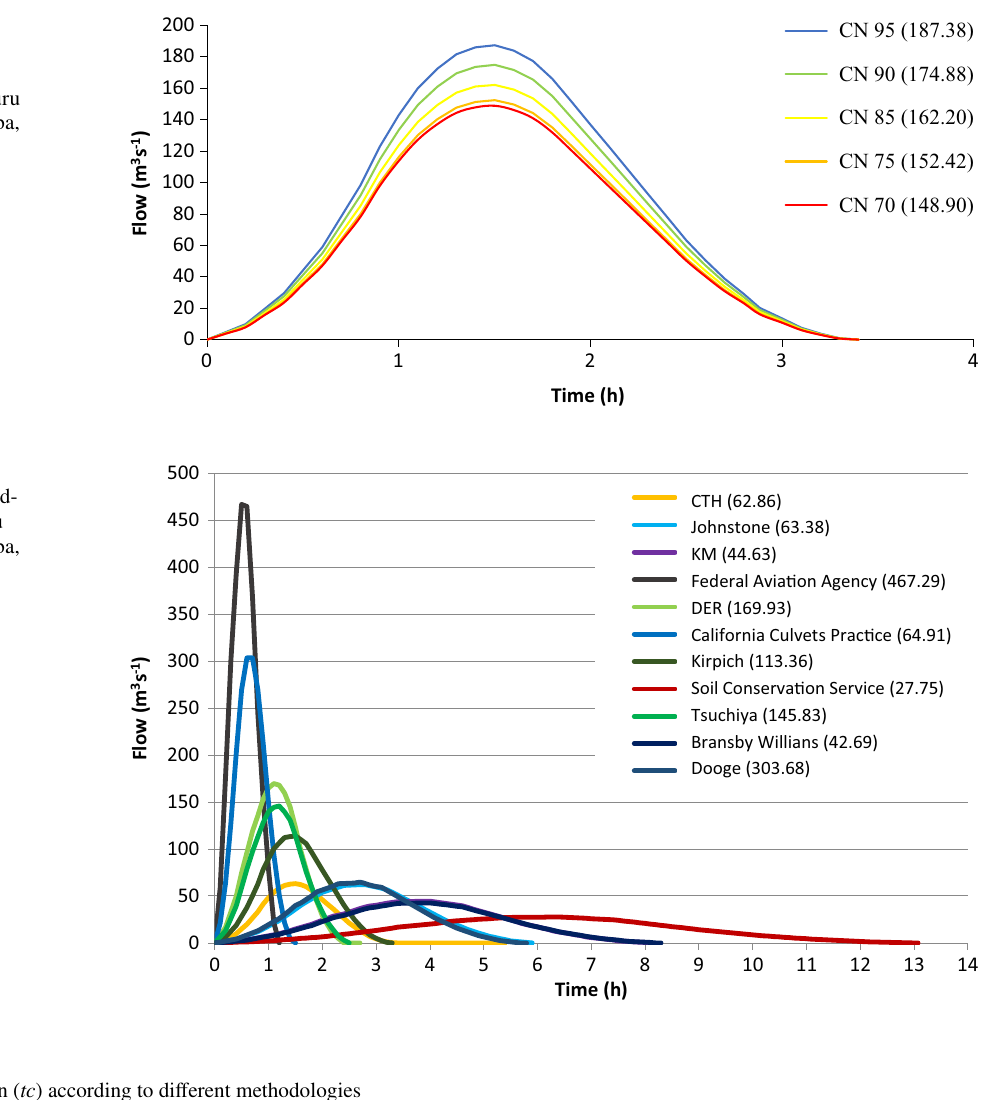
Table 5 Time of concentration ( tc ) according to different methodologies Method Bransby Willians Dooge Johnstone Tsuchiya Soil Con-